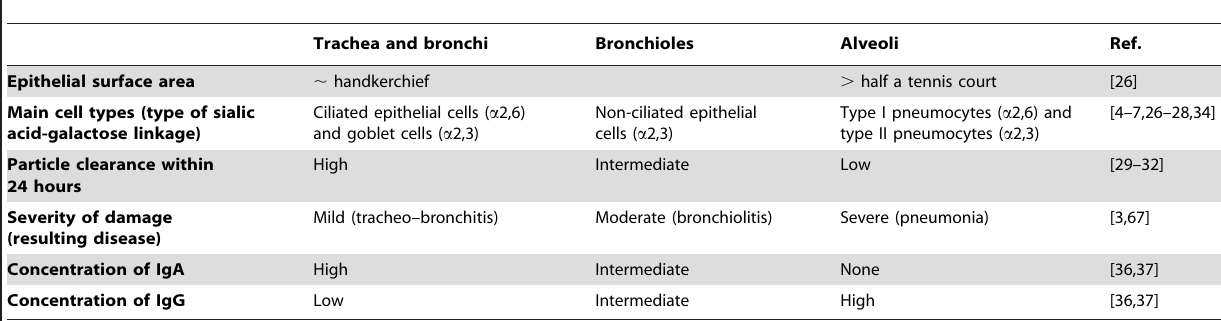
Table 1. Characteristics of the human respiratory tract.